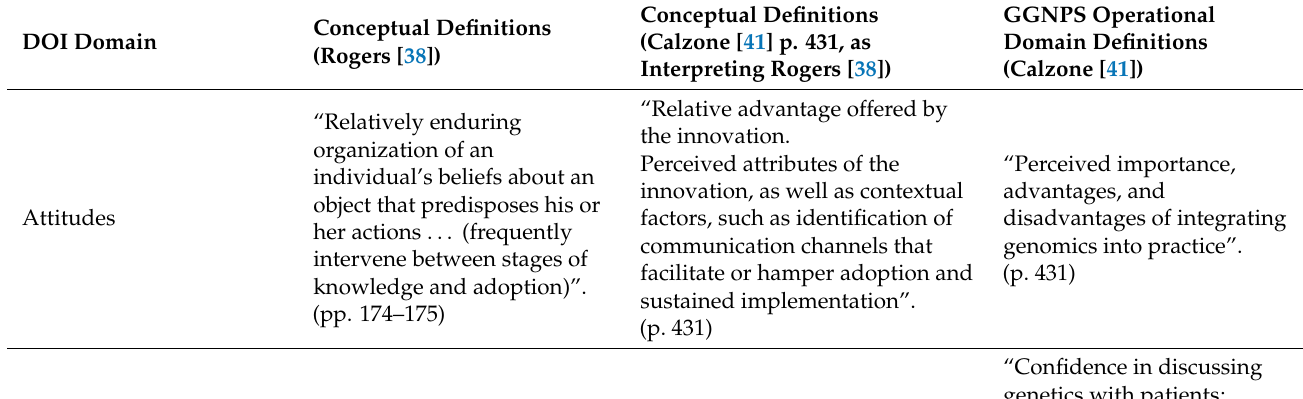
Table 1. Conceptual and operational definitions of the DOI [38] and GGNPS